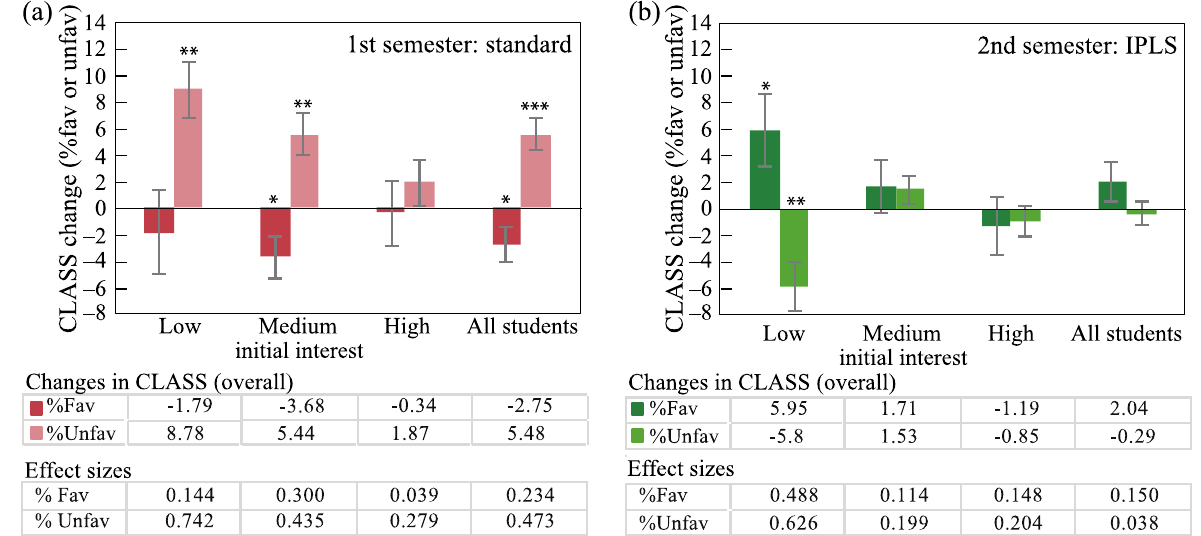
FIG. 1. Changes in overall CLASS responses (post-pre) for all IPLS students with matched data over the three years of the study ( N ¼ 83 ), obtained from (a) first semester standard course and (b) second semester IPLS course. Results are shown both for the entire population and for low, medium, or high interest groups (Table IV). Percent favorable and % unfavorable scoring is done as described in Ref. [13]. The asterisks indicate statistical significance (* p < 0 . 05 , ** p < 0 . 01 , *** p < 0 . 001 ); error bars show the standard error of the mean. Effect sizes were calculated using Cohen ’ s d . The corresponding data are provided in Table S1